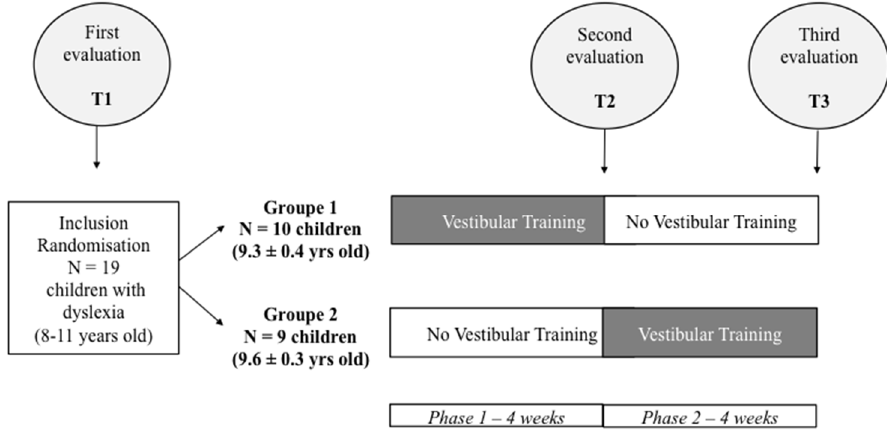
Figure 1. Illustration of the crossover interventional experimental design.